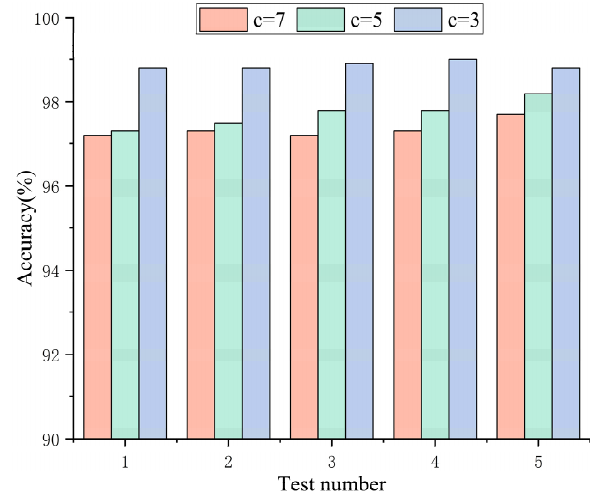
Figure 9. The influence of the filter scale.